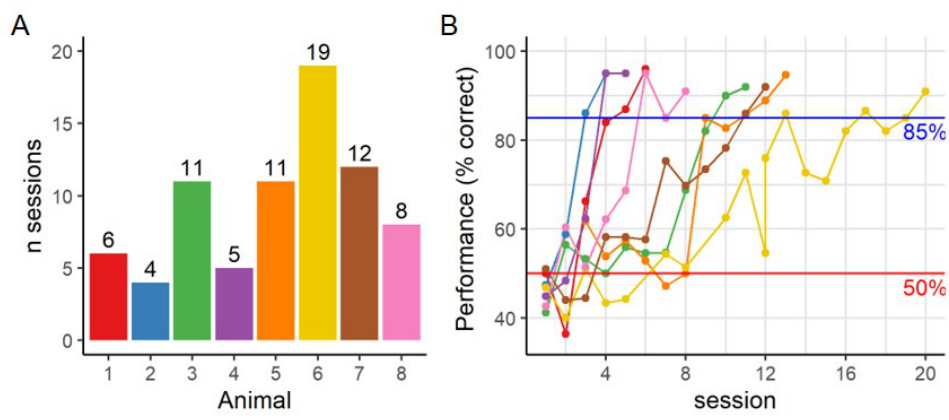
Figure 2. Acquisition phase. ( A ) Number of session required to reach criterion ( > 85% for 2 days) for each animal. ( B ) Individual learning curves with daily performance during this acquisition phase (5 c/screen). Colors refer to individual animals and remain consistent across figures. − 85% criterion; − 50% chance